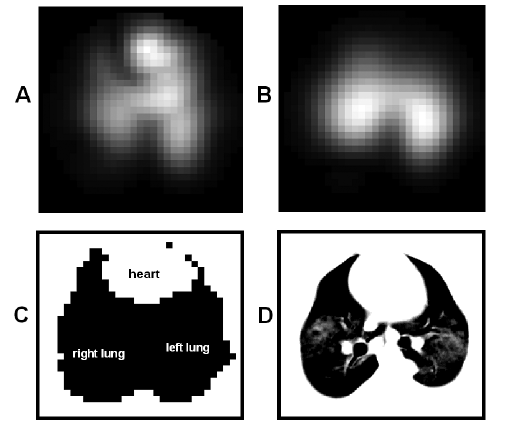
Figure 6 - The EIT image of the lung before fuzzy analysis: lung perfusion (A) and lung ventilation (B). The total lung map through fuzzy model (C) and CT-scan image (D)